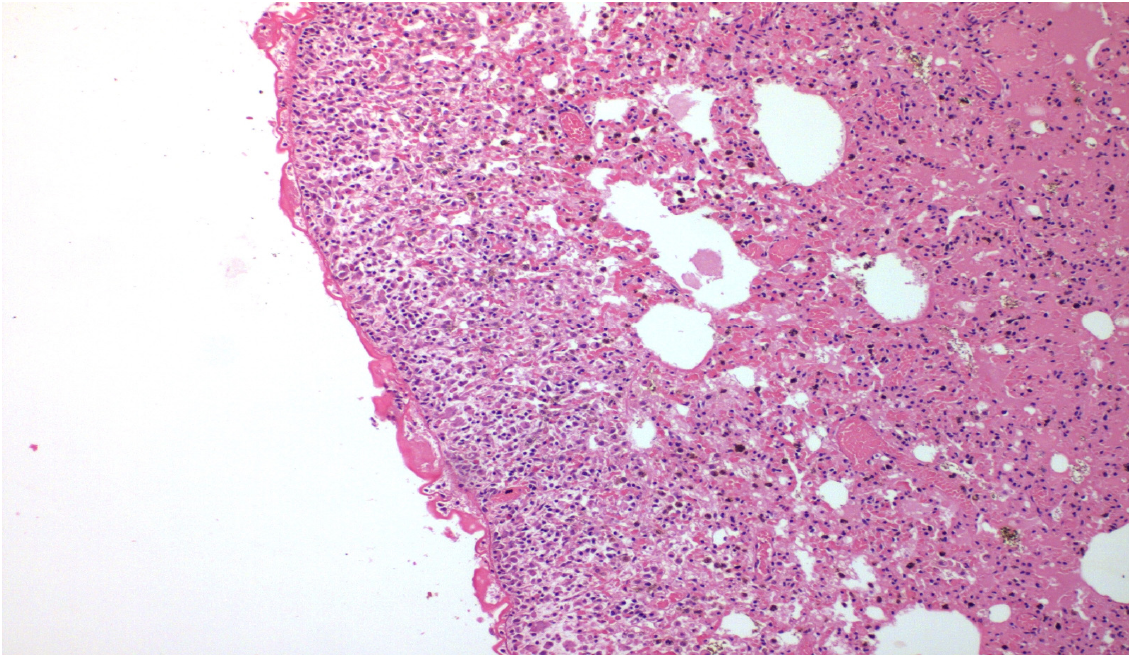
Figure 3. ×100 Hematoxylin-Eosin stain—after PRP installation, there is significant fibrosis peripherally.